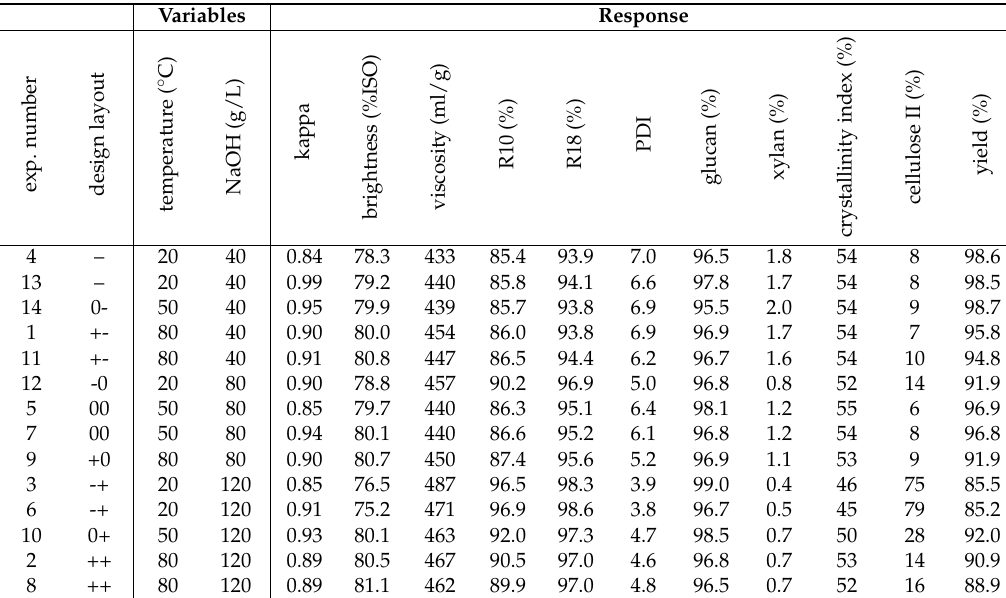
Table A1. DoE layout and